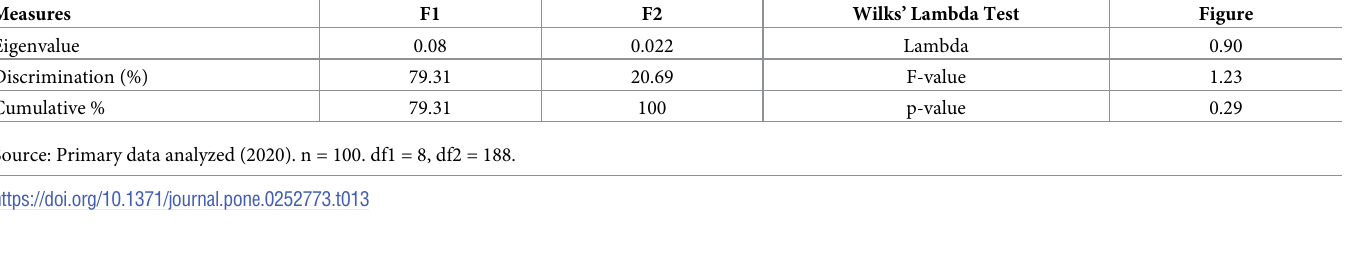
Table 13. Discriminant functions of inter-organizational trust and the simultaneous test. Measures F1 F2 Wilks’ Lambda Test Figure Eigenvalue